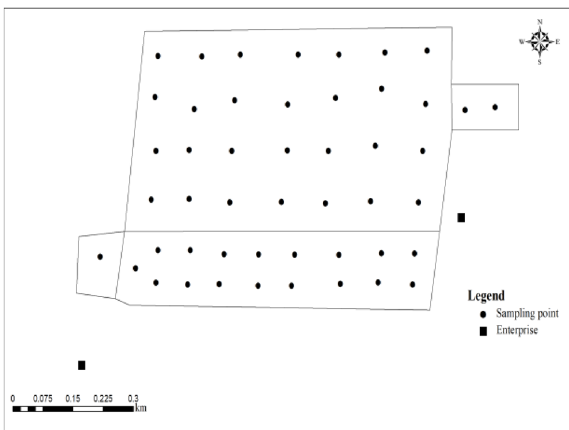
Figure 2. Location of sampling points in Anxin